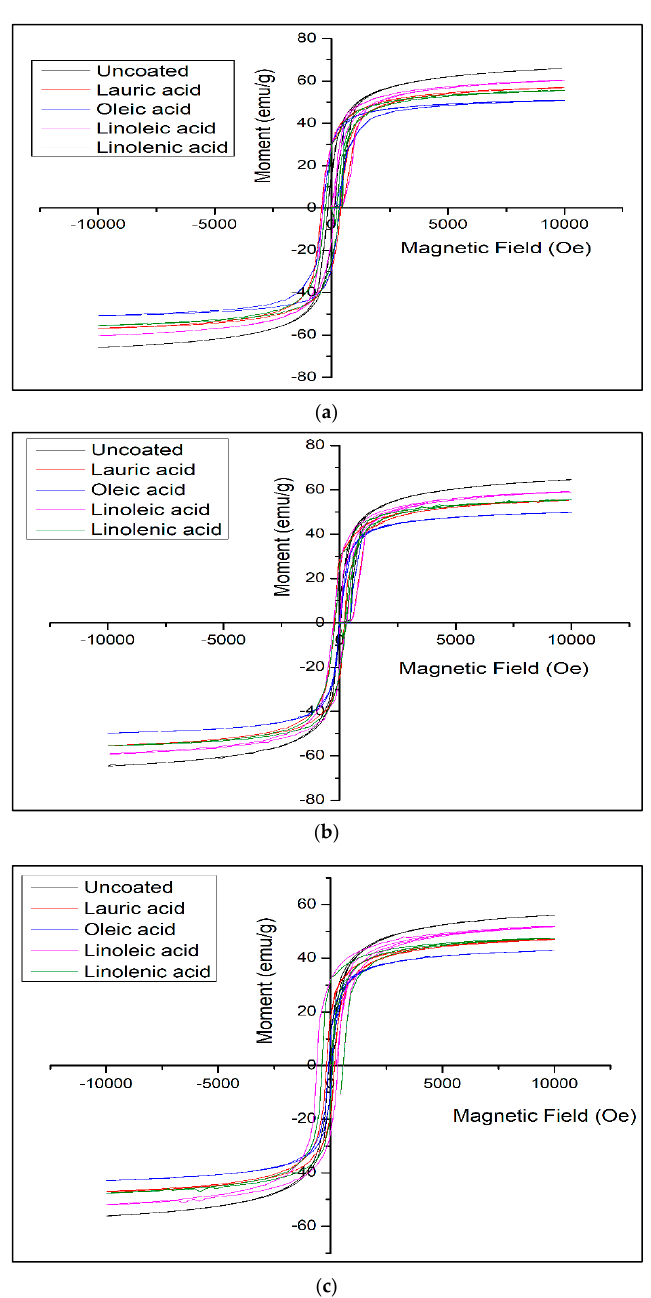
Figure 8. Comparison of M H curve for uncoated MNPs with surfactant-coated MNPs at ( a ) 10 K, ( b ) 100 K, ( c ) 300 K. The variation of magnetic properties of all surfactant hybrids in comparison with uncoated MNPs has been tabulated below in Table 2. Table 2. Variation of magnetic properties of surfactant hybrids in comparison to uncoated MNP. MNPs Coated by